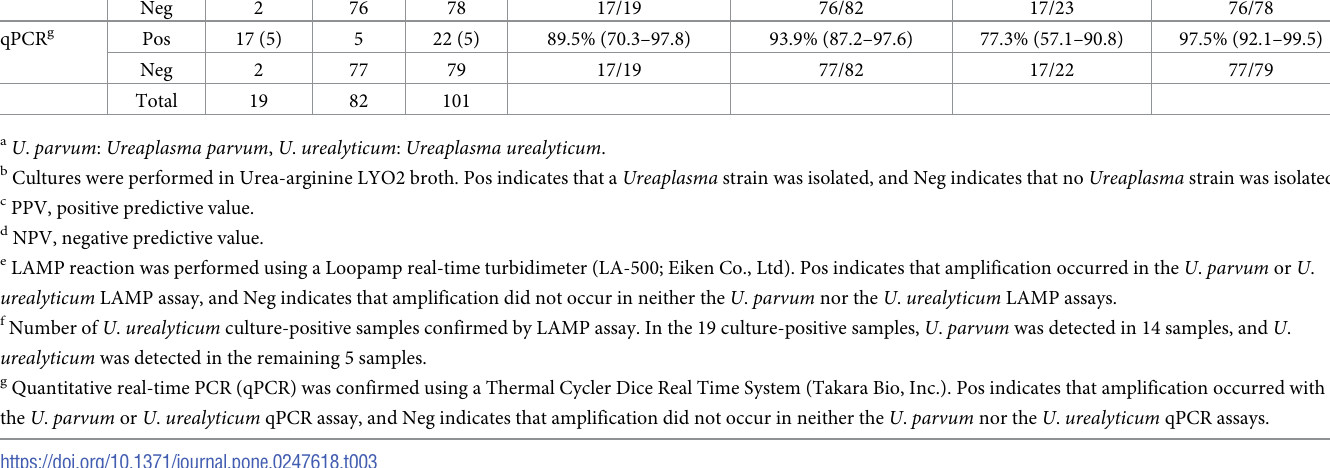
S1 Table. LAMP primer sequences and quantitative real-time PCR primer sequences in this study.